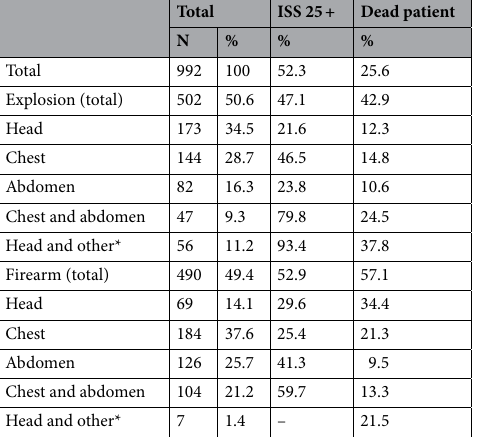
Table 2. Distribution of internal injuries according to injury mechanism by body regions and their effects. *Head and other include: head and chest, head and abdomen and head, and both chest and abdomen. ISS Injury severity score.